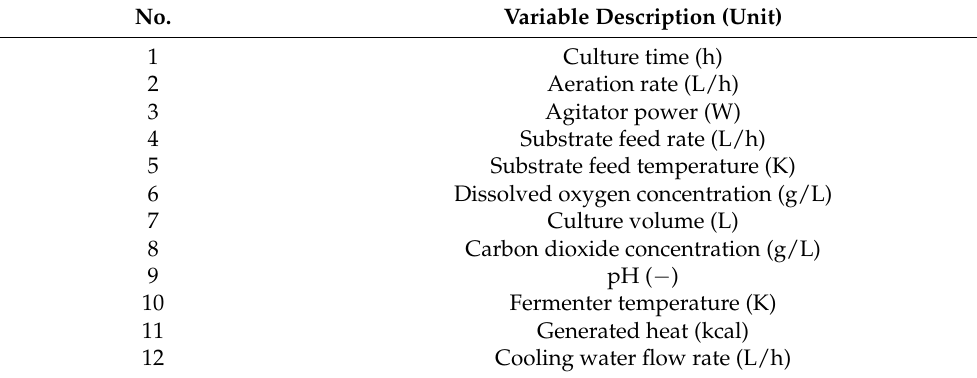
Table 1. Input variables for soft sensor development in the penicillin fermentation process.